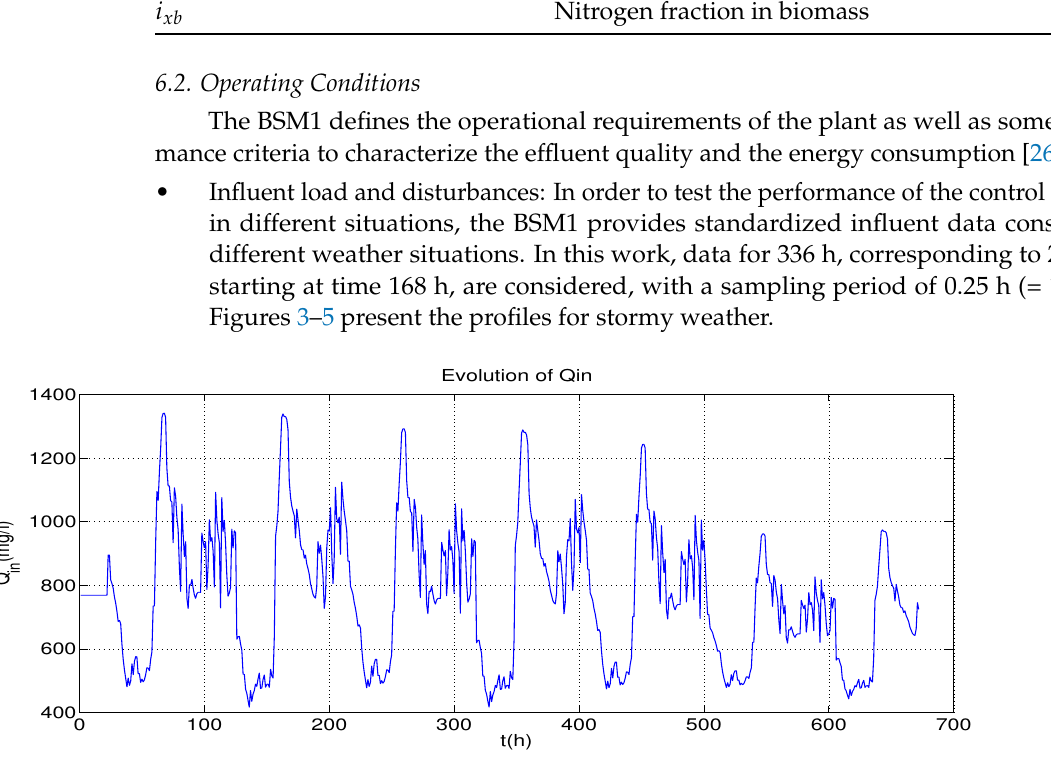
Figure 3. Influent flow Q in for stormy